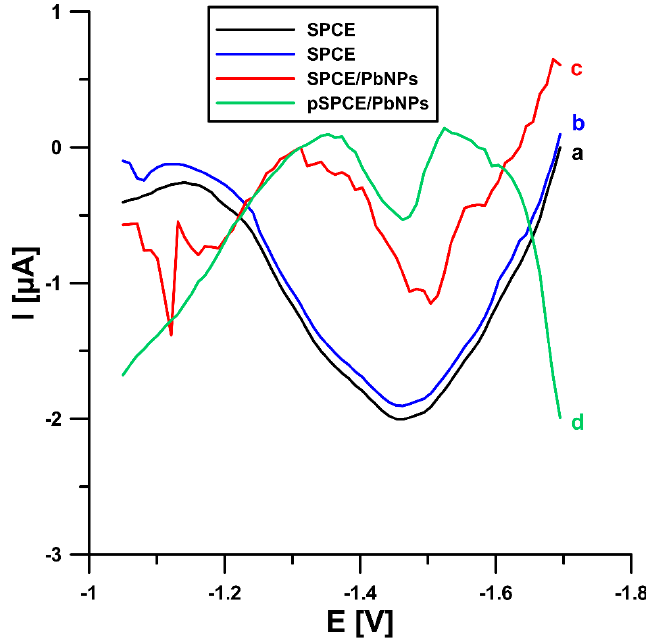
Figure 1. Comparison of the SWAdSV response for: (a and b) unmodified SPCE, (c) SPCE/PbNPs, and (d) pSPCE/PbNPs. BLM concentration of 2 (a, c, and d) and 5 (b) nM. E acc. = − 1.0 V, t acc. = 120 s, f = 50 Hz, E SW = 50 mV, and Δ E = 10 mV.